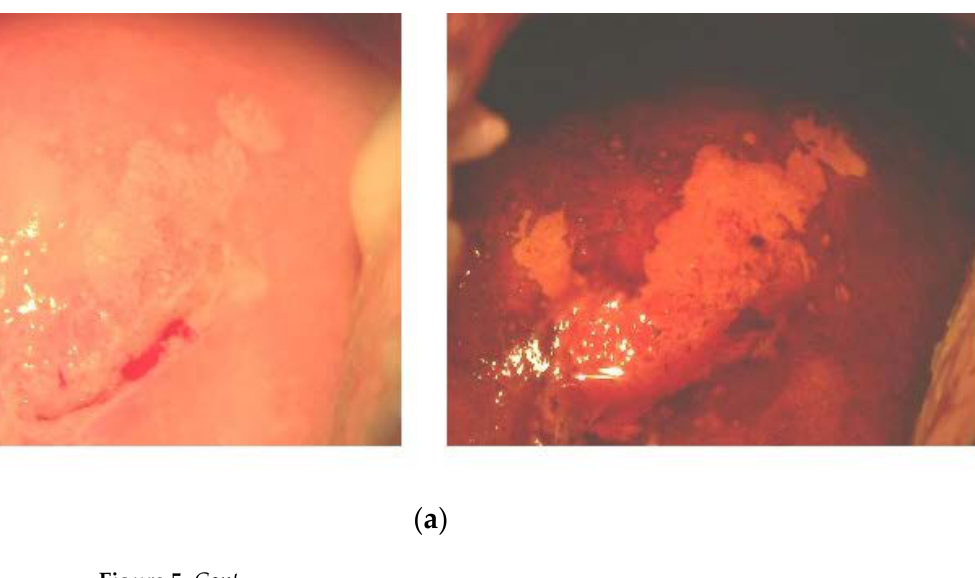
( b ) Figure 5. Typical colposcopy of CIN I and CIN II lesions before ( a ) and after ( b ) administration of antioxidants. ( a ) Before administration of antioxidants (ectopic transformed areas, squamous cell metaplasia, and mosaics marked by the iodine-negative areas). ( b ) After a three-month course of antioxidants (normal tissue basis, shrinkage of iodine-negative areas, and cervical coagulation). Left panels are colposcopic images without iodine staining. Right panels are colposcopic images after iodine staining. 3.4. Effects of FM Supplementation on Oxidative and Nitrosative Markers in Cervical Tissue The cervical tissue markers of oxidative and nitrosative stress appeared to be selec- tively modified by the FM treatment of the CIN I-II patients (Table 3). After 3 months, MPO activity was significantly ( p < 0.01) decreased, as well as nitrate/nitrite and nitrotyro- sine levels ( p < 0.05). Catalase activity showed a trend toward reduction, whilst isopros- tane and